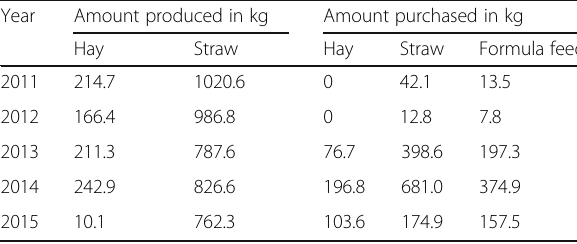
Table 5 Adaptation to climatic change via cattle feeding Year Amount produced in kg Amount purchased in kg Hay Straw